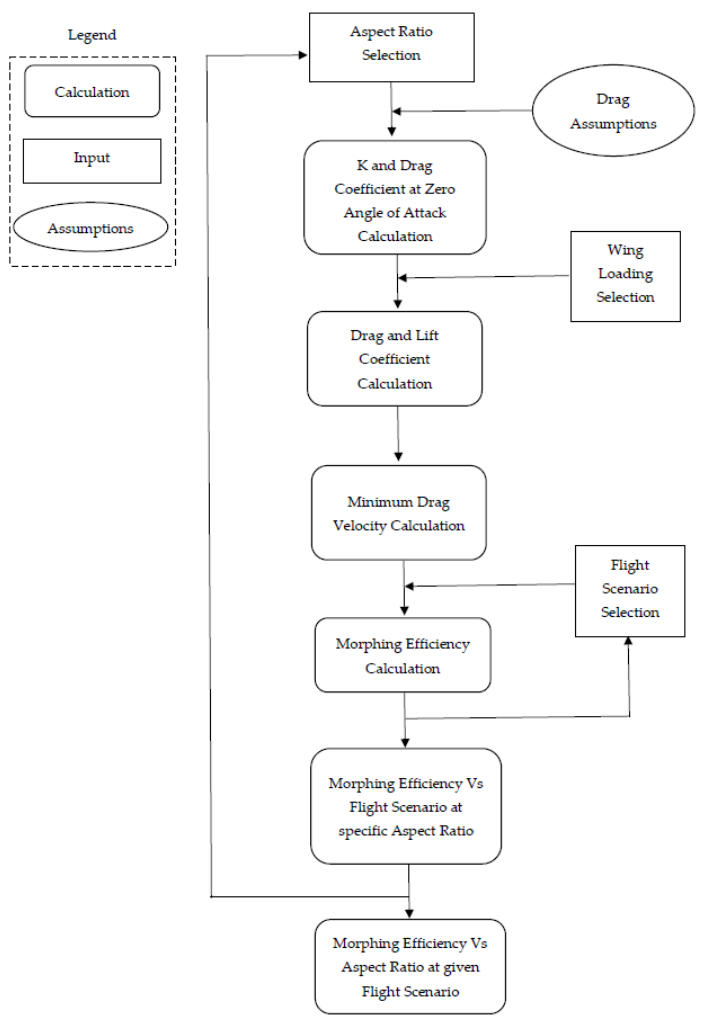
Figure 6. Block diagram of the morphing efficiency analysis